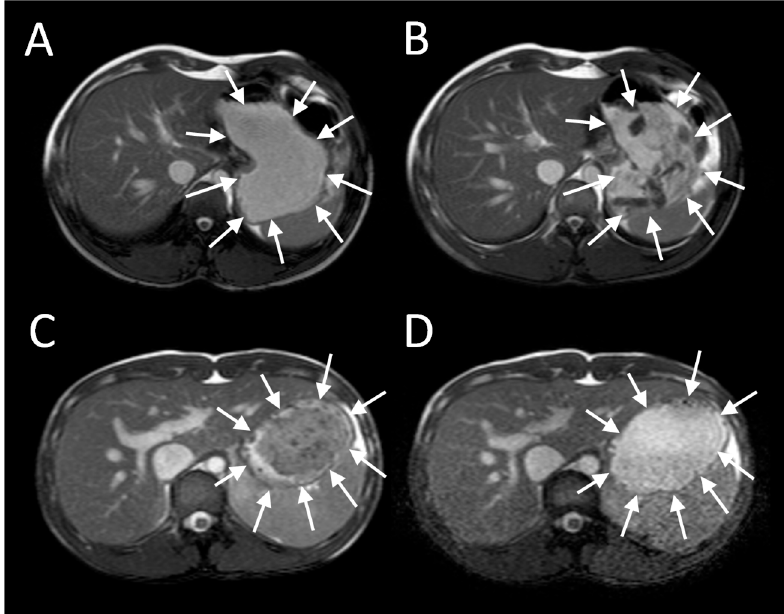
Figure 1. Gastric MRI images of different mixed solid/liquid meals: ( A ) Soup, ( B ) roasted chicken and vegetables, ( C ) whole wheat bread and ( D ) rice pudding. Reproduced from [4], Springer Nature 2013, under Creative Commons CC-BY license and from [5], Oxford University Press 2012, with permission.